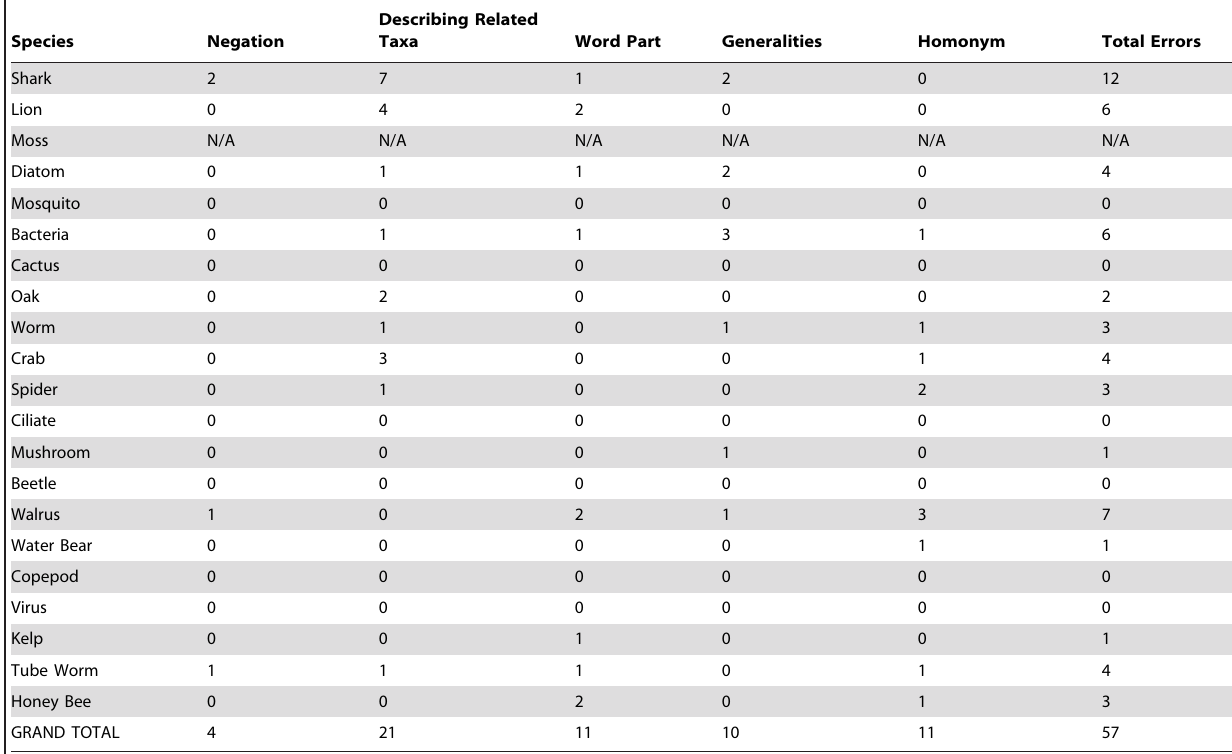
Table 2. URI Annotation